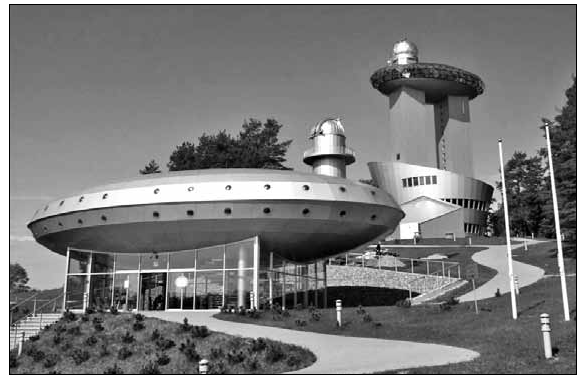
fig. 8. lithuanian Museum of Ethnocosmology, in Molėtai region, by architects Krištapavičius and Gudaitis, 2002–08